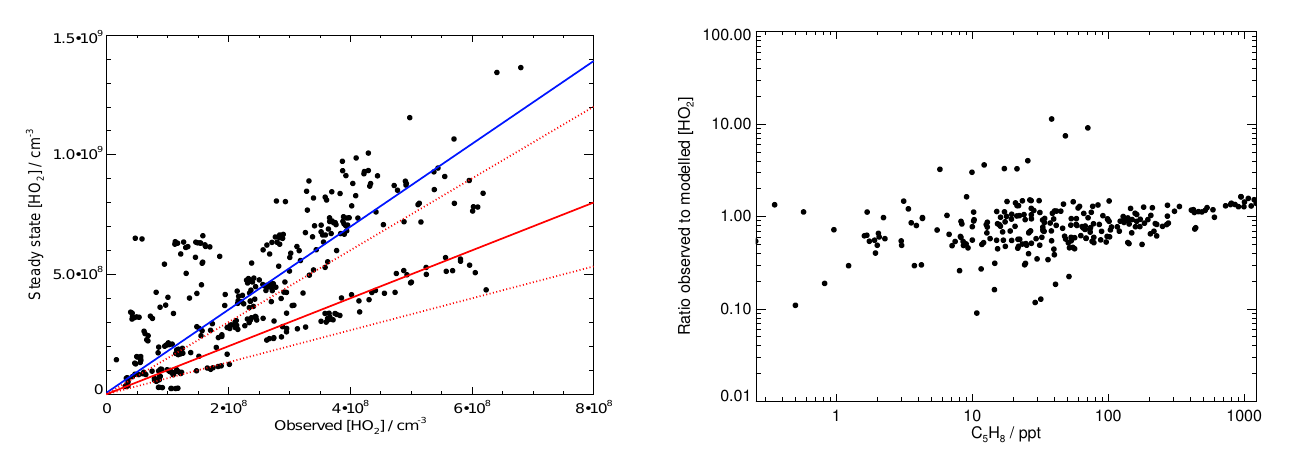
Fig. 5. Comparison between observed HO 2 concentrations and a simple steady state model. The 1:1 line is shown by the solid red line, with dashed red lines indicating 50% limits on the 1:1 line. The best fit to the data is given in blue and is described by y = (1.73 ± 0.16) x + (0.62 ± 4.33) × 10 7 , with r 2 = 0.74. While the apparent separation of the data into two regimes does correspond to data points with high isoprene and those with low isoprene, discrimination on the basis of geography is not possible since both regimes contain a mixture of boundary layer and free troposphere data points over both forest and Sahel.